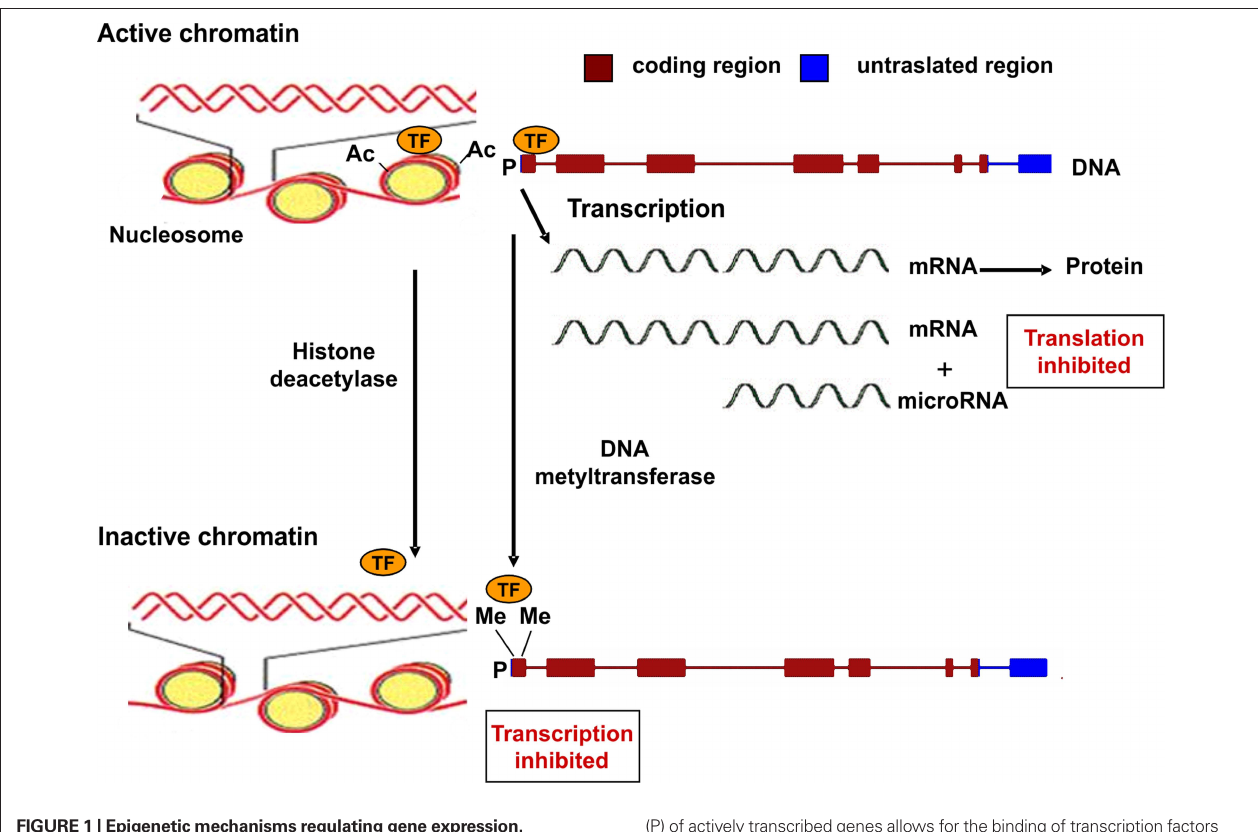
(P) of actively transcribed genes allows for the binding of transcription factors (TF). Transcriptionally inactive chromatin is characterized by histone deacetylation, promoter CpG methylation (as indicated by the presence of methyl groups, Me), and decreased binding of transcription factors. A further level of epigenetic control is provided by microRNA molecules (19–22 nucleotides in length) which bind to mRNA thus reducing the rate of